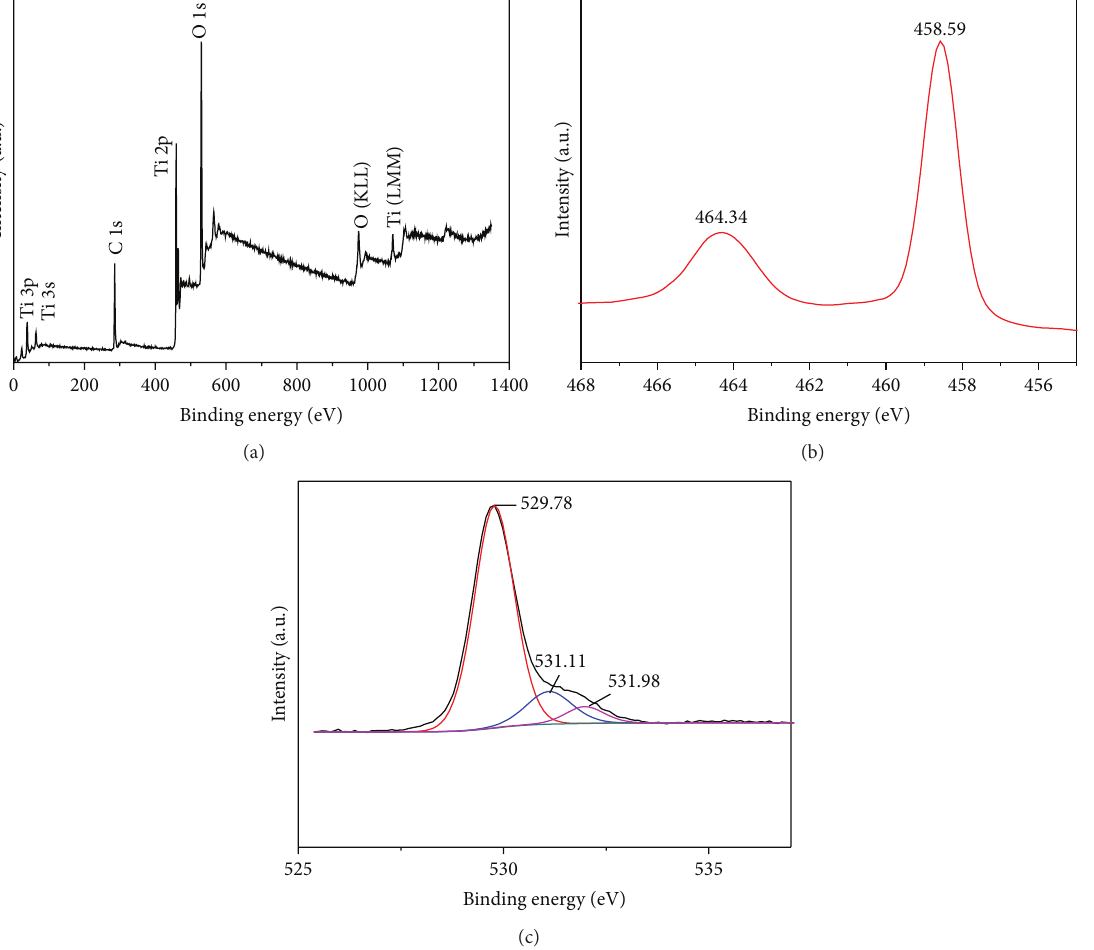
Figure 6: XPS spectra of TiO 2 aerogel (a) total spectrum; high-resolution spectrum of the (b) Ti 2p and (c) O 1s